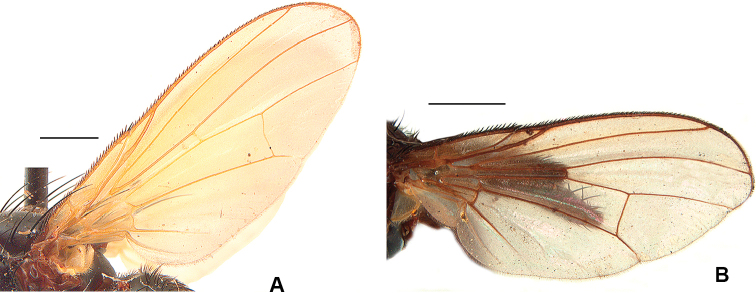
Female wings AD.
flavinervisBD.
aldrichi. Scale bars: 1 mm.